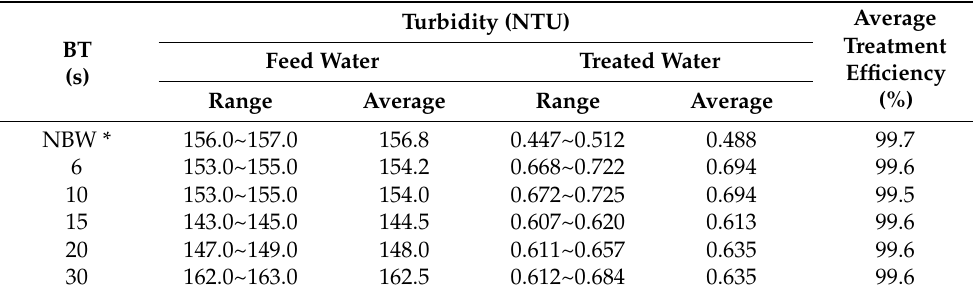
treatment efficiency (%)